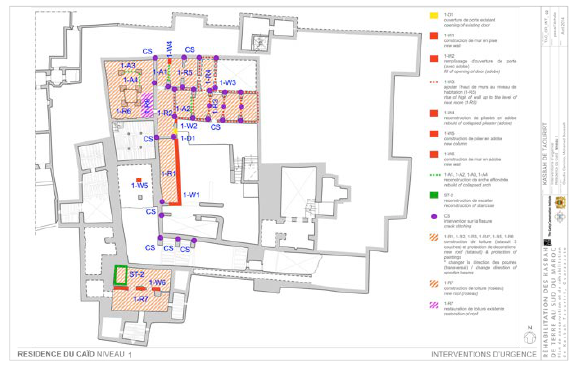
Figure 8: Interventions planned using the measured drawings of the Caïd